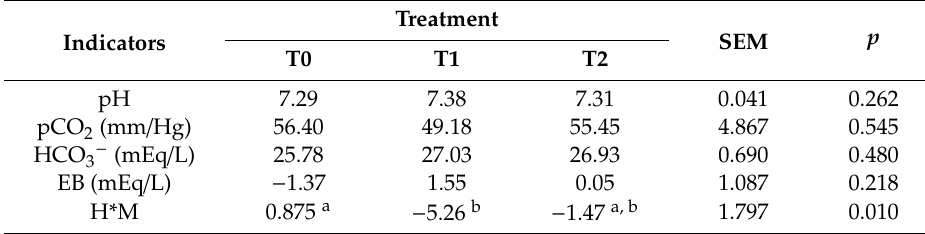
Table 4. E ff ect of oral administration with Lactobacillus plantarum CAM6 on the acid-base balance of weaned pigs.